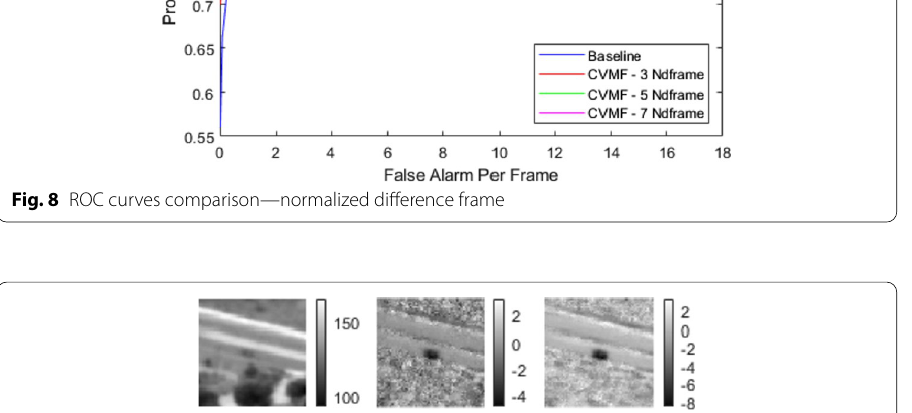
Fig. 9 Target enhancement (left—original, center- baseline normalized difference, right—CVMF 5-frame